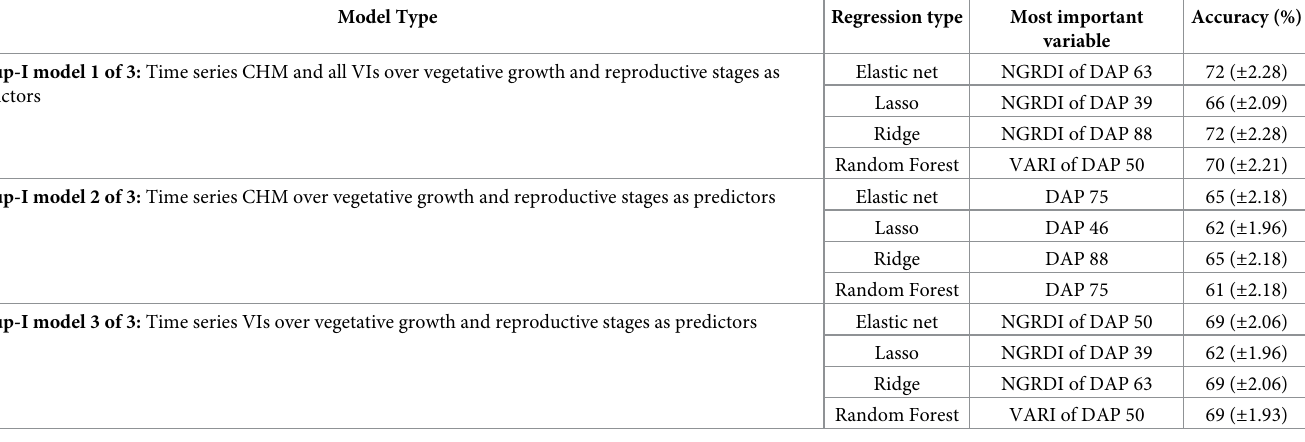
Table 2. Results of Group-I models. The results include results from regressions for each model, and most important variables for each model for each regression type, and accuracies of each model for each regression type. Model